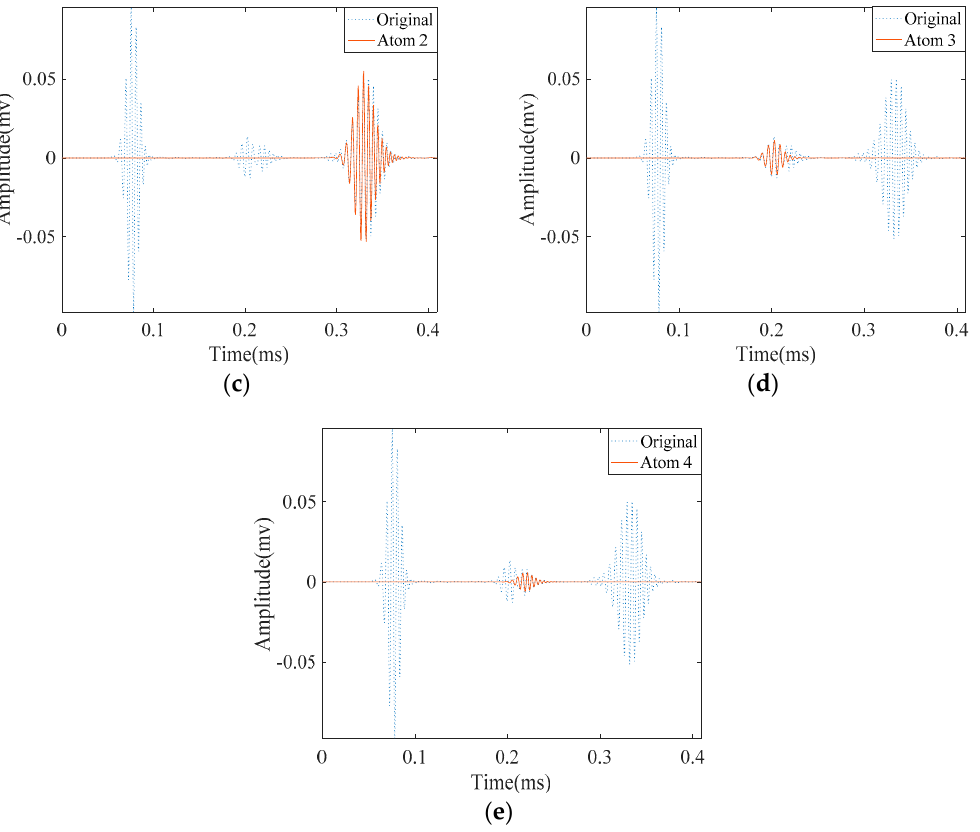
Figure 11. Results obtained by applying SDMP to the simulation signal in a pipe with 27 mm length notch: ( a ) the original signal; ( b ) approximated atom 1—the direct signal; ( c ) approximated atom 2—the reflection from the pipe end; ( d ) approximated atom 3—the reflection from the first edge of the notch; and ( e ) approximated atom 4—the reflection from the second edge of the notch.